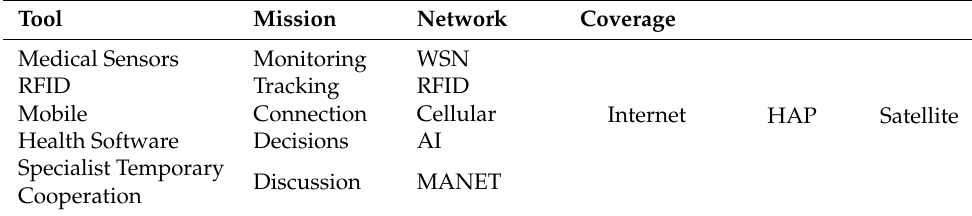
Table 2. Needs for the use case